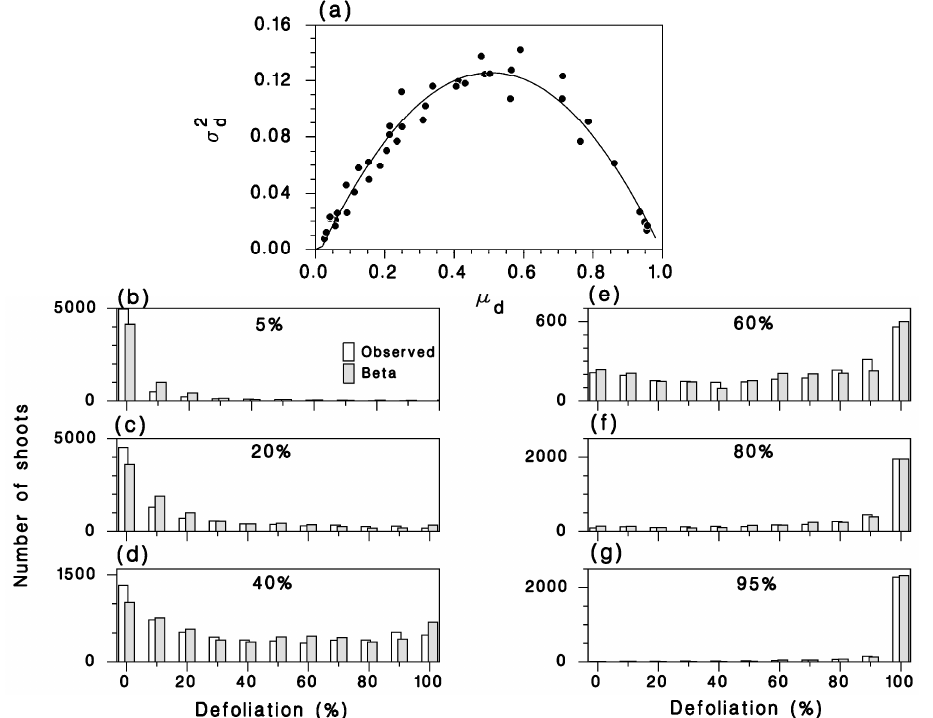
Figure 5. ( a ) Relationship between stand-level variance σ d2 and mean µ d defoliation expressed as a proportion, with the line from Equation (7). ( b – g ) Observed and Beta frequencies of shoot-level defoliation for ranges of stand-level defoliation from 5% to 95%. Data from balsam fir in the lower St. Lawrence region,